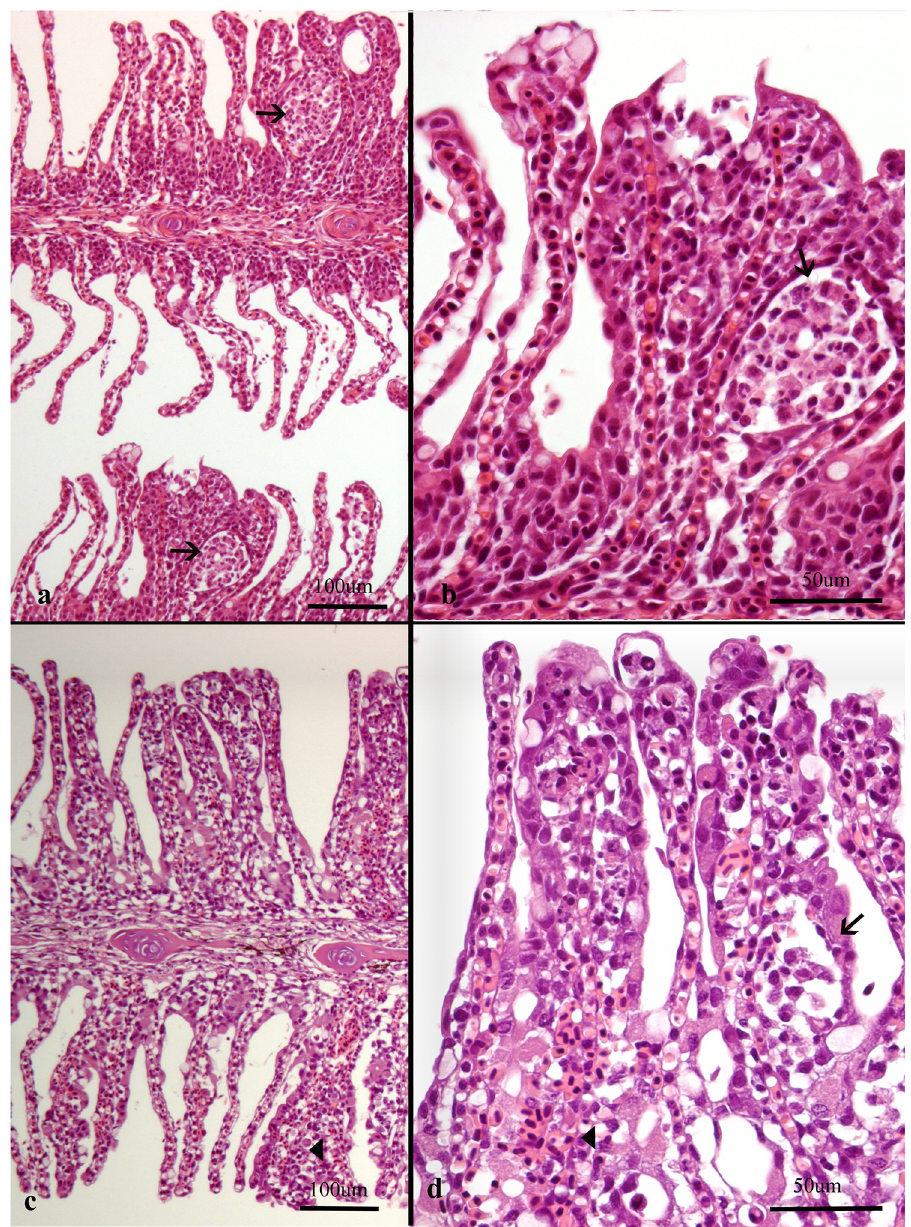
Fig 4. Histological sections of gills from Atlantic salmon. Note that plane of section is consistently on the efferent side of the gills in all images as judged by the small amount of filament cartilage. (a-b) Gills from farm 22 were dominated by Ca . Branchiomonas cysticola. (a) Epithelial cell hyperplasia and pustules (arrows), scored 5 (b) large pustule (arrow) in proliferative lesion (c-d) Gills from farm 3 were dominated by Ca . Branchiomonas cysticola and Desmozoon lepeoptherii . Haemorrhages (arrowhead), scored 4. (d) subepithelial leukocytes (arrow), scored 5.